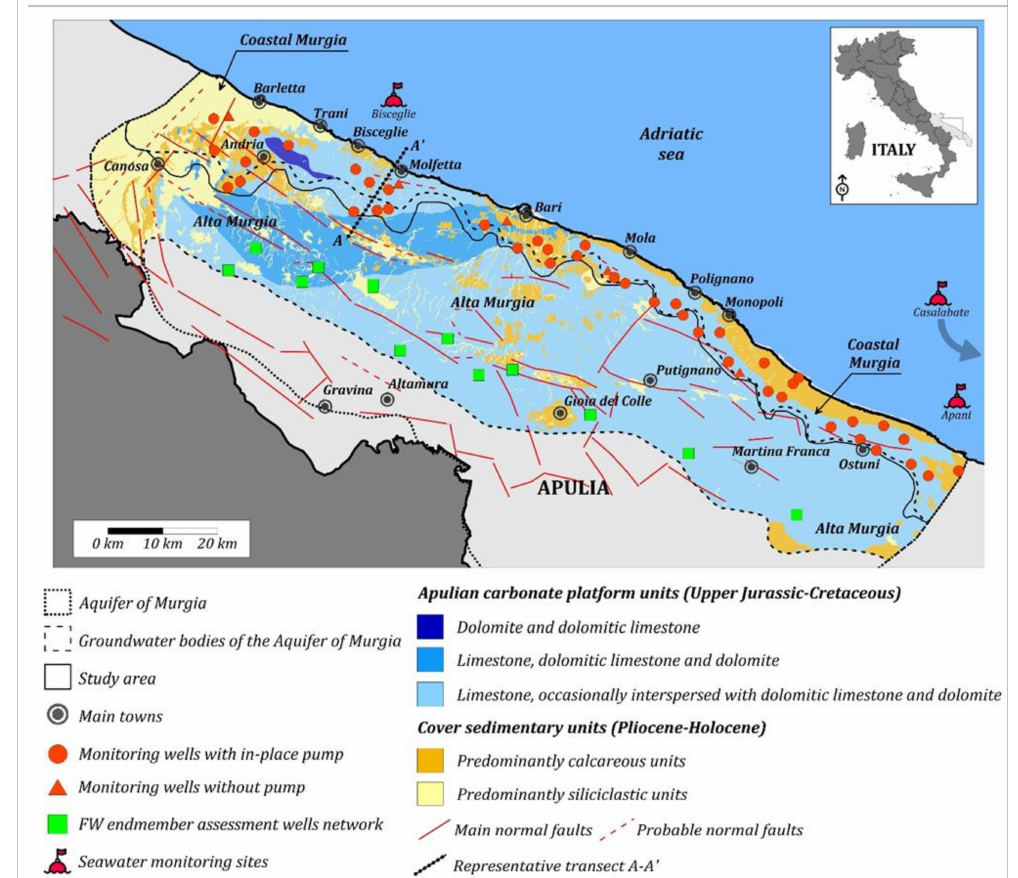
Figure 1. Geological map of Coastal Murgia and current monitoring